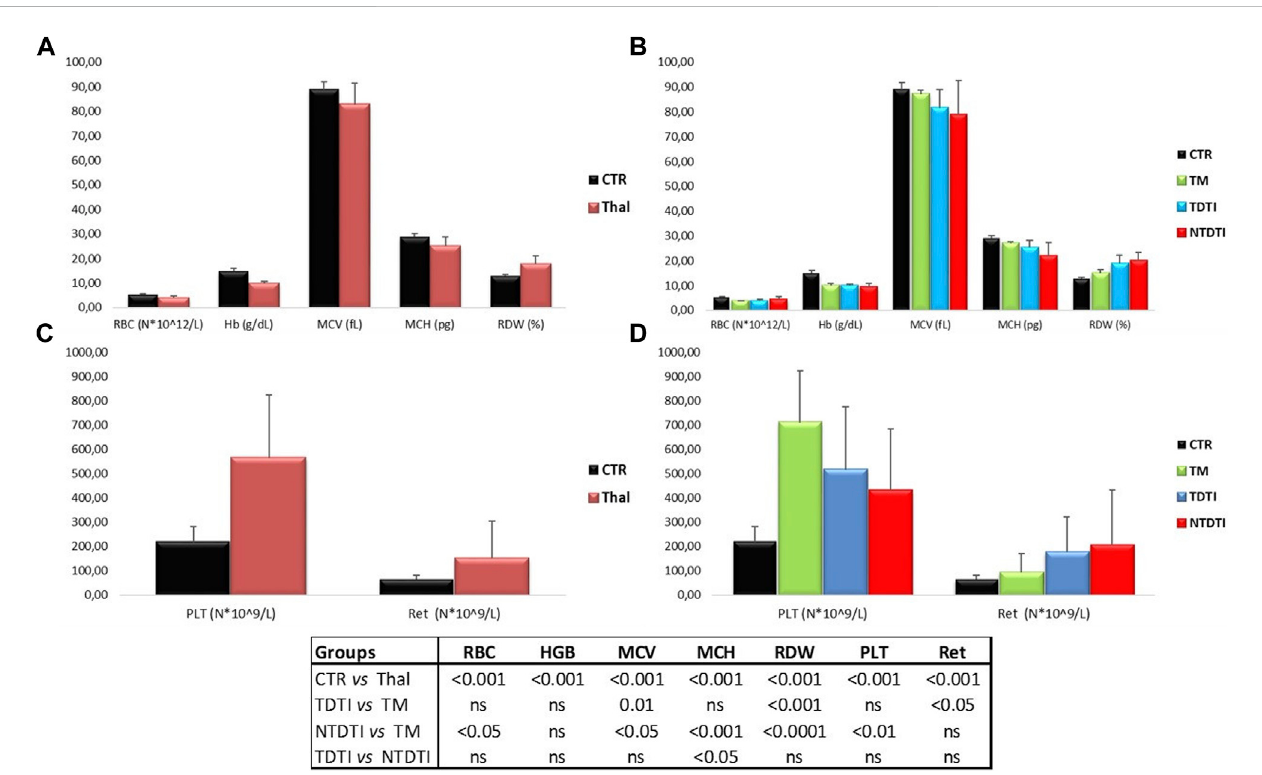
FIGURE 1 Hematological parameters from thalassemia patients and healthy subjects: (A) and (C) Comparisons between healthy subjects (CTR) and all thalassemia patients (Thal); (B) and (D) Comparisons between CTR and patients groups divided according to the severity of the disease: TM: thalassemia major; TDTI: transfusion-dependent thalassemia intermedia; NTDTI: non-transfusion-dependent thalassemia intermedia; RBC: red blood cell; Hb: Hemoglobin; MCV: meancellvolume;MCH:meancellhemoglobin;RDW:RedbloodcellsDistributionWidth;PLT:plateletcount;Ret:reticulocytecount;ns:notsigni fi